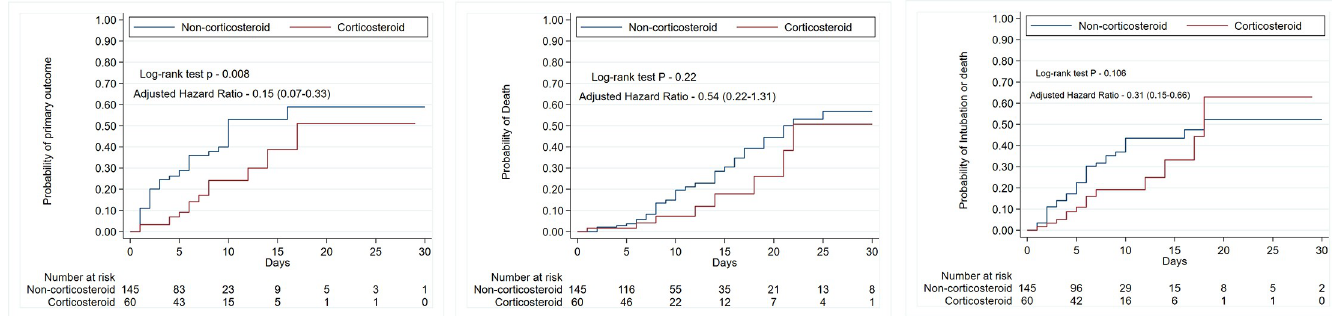
Fig 1. Kaplan-Meier curve of patients with non-severe COVID-19 pneumonia who received and did not receive corticosteroids. Panel (A) Primary Outcome. Primary outcome is a composite of ICU transfer, intubation or death. Panel (B) In-hospital Mortality. Panel (C) Composite of intubation or death.